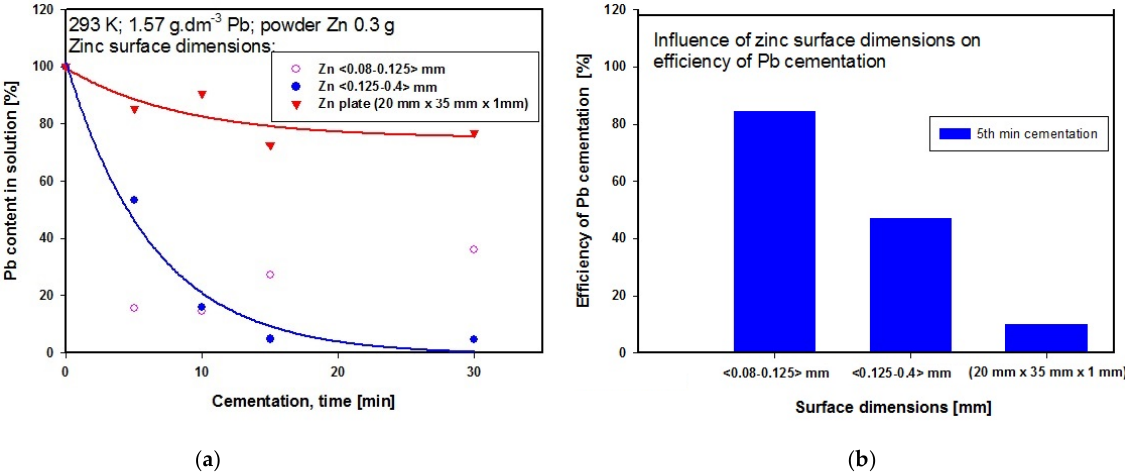
Figure 7. ( a ) Influence of cementer Zn particle size on Pb concentration in solution during cementation at 293 K ( b ) Comparison of Pb cementation efficiencies after 5 min procedure at 293 K using different Zn particle sizes.